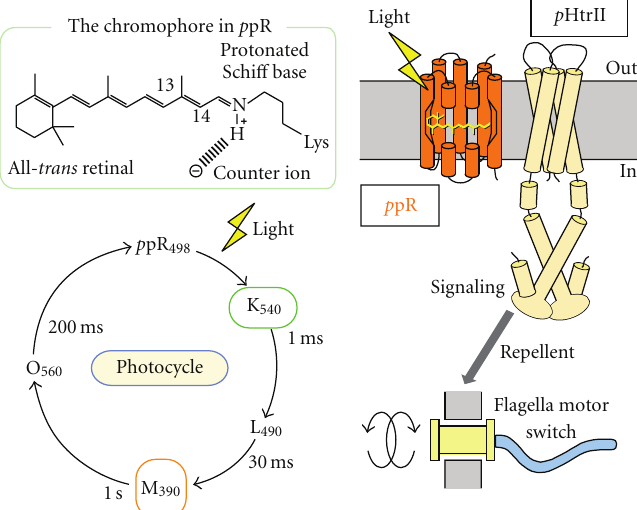
Figure 1: Schematic representation of pharaonis phoborhodospin ( p pR) and its transducer ( p HtrII). p pR and p HtrII form a 2:2 complex in the membrane, former of which contains all- trans retinal as the chromophore. p pR absorbs maximally at 498 nm, and light absorption initiates the photocycle. Light signal is transferred into the cytoplasmic domain through the protein structural changes of p HtrII.